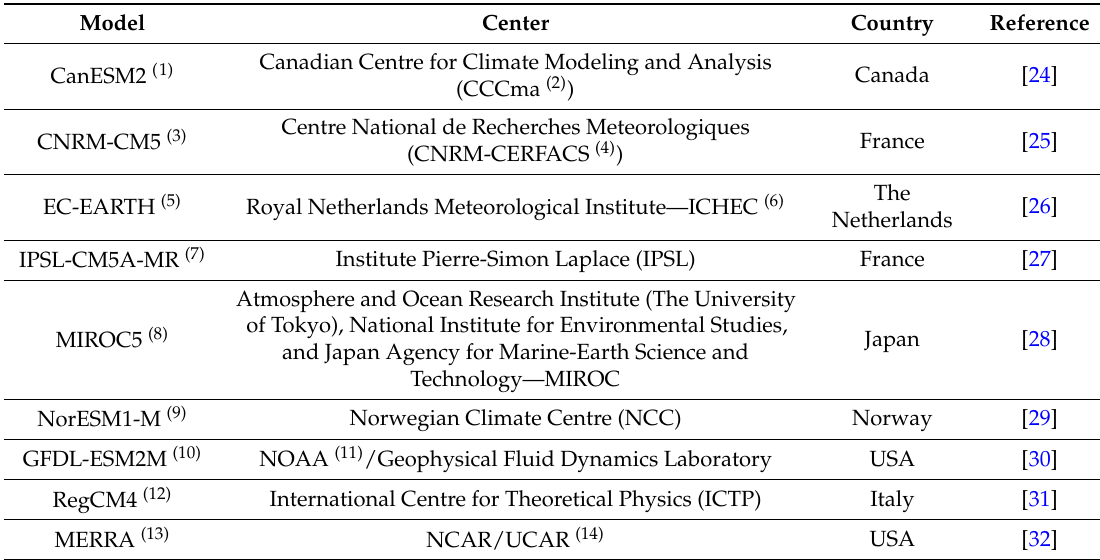
Table 2. Climate models evaluated in this study and their